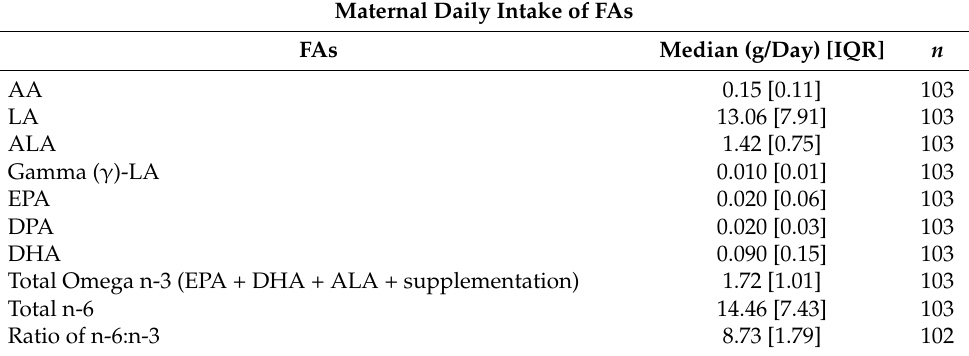
Table 1. Maternal dietary intakes.